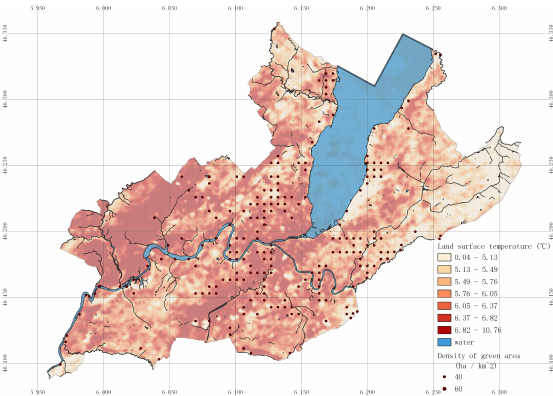
Figure 15. Density of green area between 40 and 60 ha/km 2 in winter in